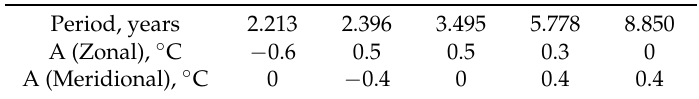
Figure 10. A comparison of the Oceanic Niño Index with a combination of five subdecadal tidal components. Table 10. Amplitudes for the five subdecadal tidal components in a simulation of the ONI. The ONI lags the tidal components by 0.22 years.